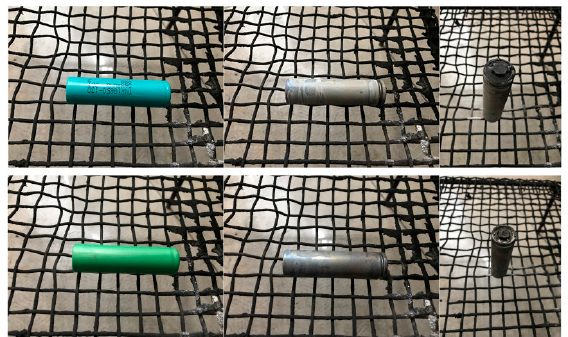
Figure 6. Photographs of batteries before and after burning.